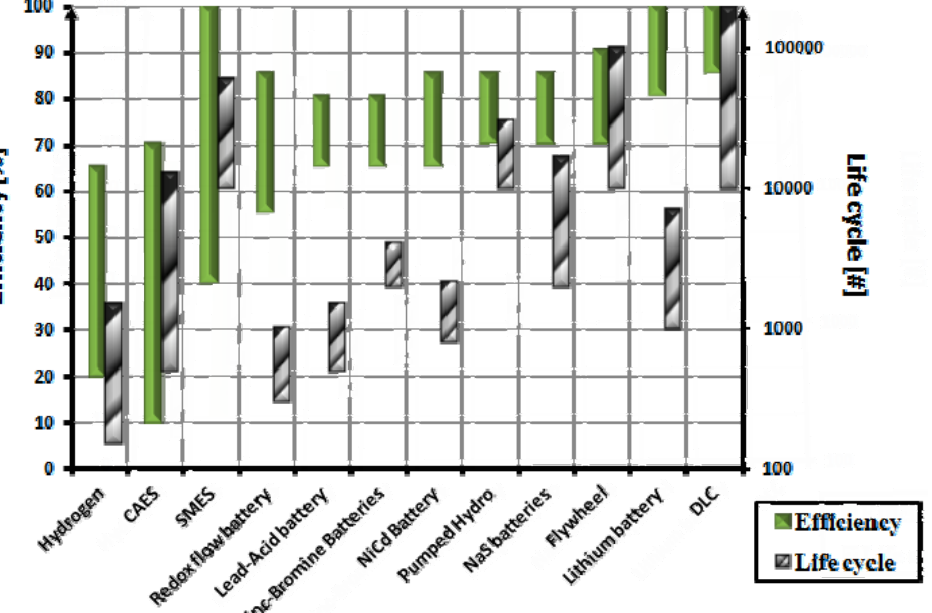
Figure 2. Energy storage comparison, based on efficiency and life